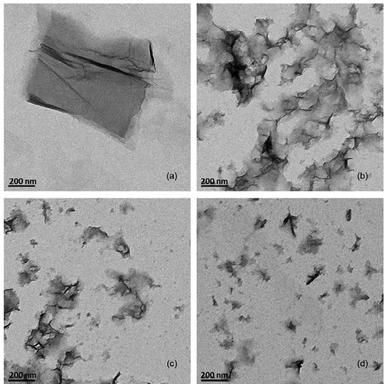
TEM images of GO and product with free chlorine under UV irradiation (2000 µW/cm2 ) for 2 h. (a) GO, (b) with 100 mg/L free chlorine at pH 5, (c) with 150 mg/L free chlorine at pH 5, (d) with 200 mg/L free chlorine at pH 5. All scale bars are 200 nm.